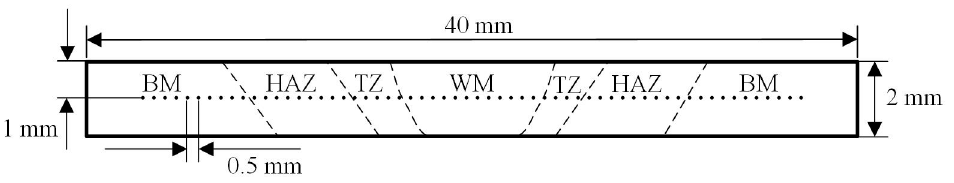
Figure 8. Schematic drawing of microhardness measuring points.